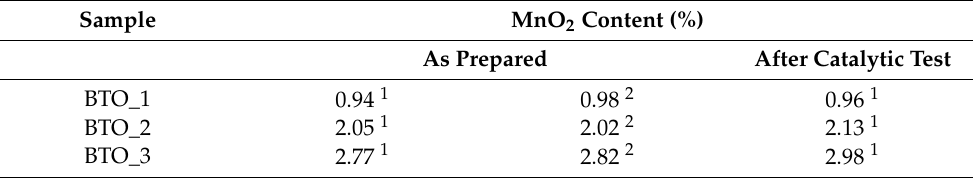
Table 1. Loading of MnO 2 in perovskite ceramics obtained from HR-CS AAS and EDS methods.